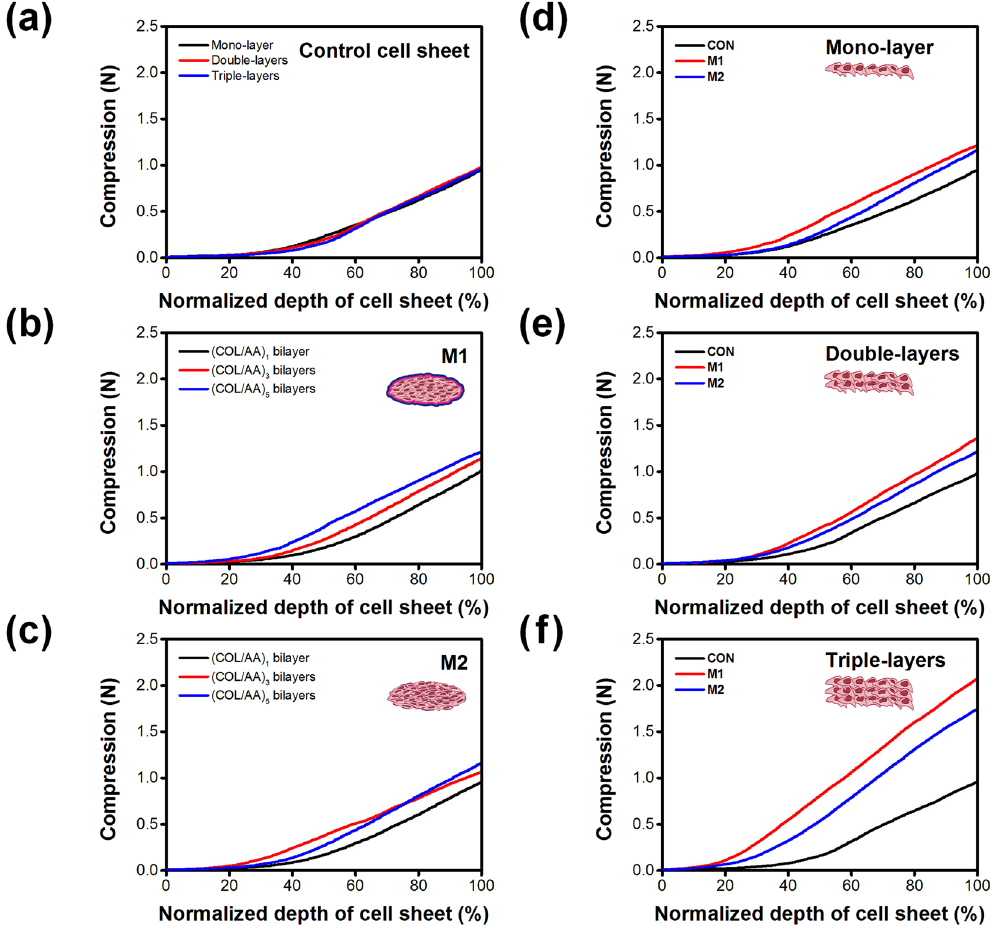
Figure 3. Mechanical properties of control cell sheets composed of one, two, or three cell layers ( a ), the effects of applying (COL/AA) n multi-layer films consisting of a diverse number of bilayers on mono-layer cell sheets via M1 ( b ) or via M2 ( c ), comparison between CON, M1, and M2 with respect to the mechanical properties of mono- ( d ), double- ( e ), and triple-layer cell sheets ( f ).